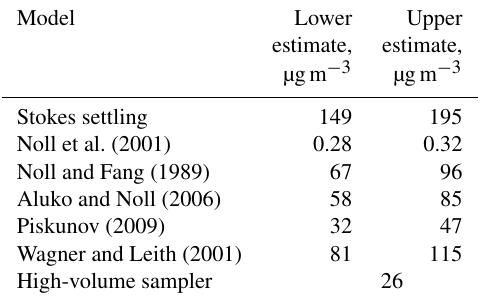
Table 1. Average dust mass concentrations, estimated from de- posited particle mass, applying various deposition models. Lower and upper refer to different dust fraction estimates (see Sect. 2.3.3).